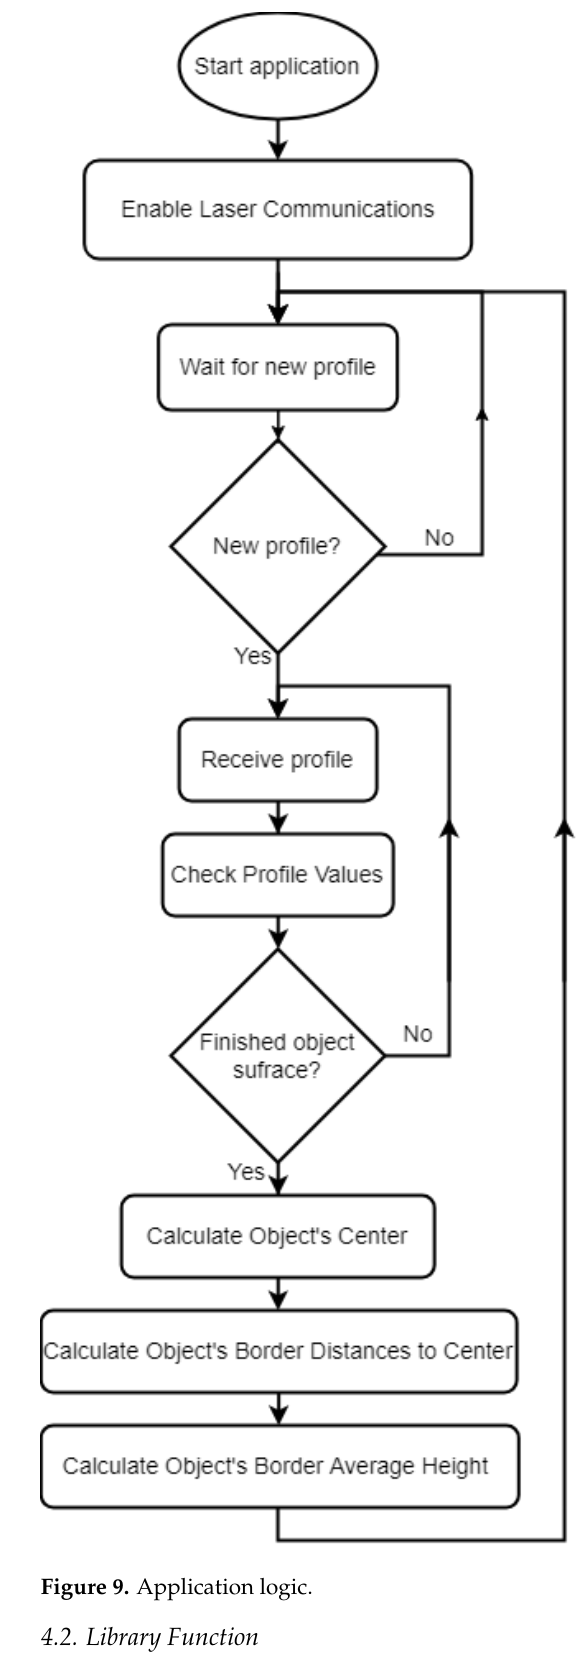
Figure 9. Application